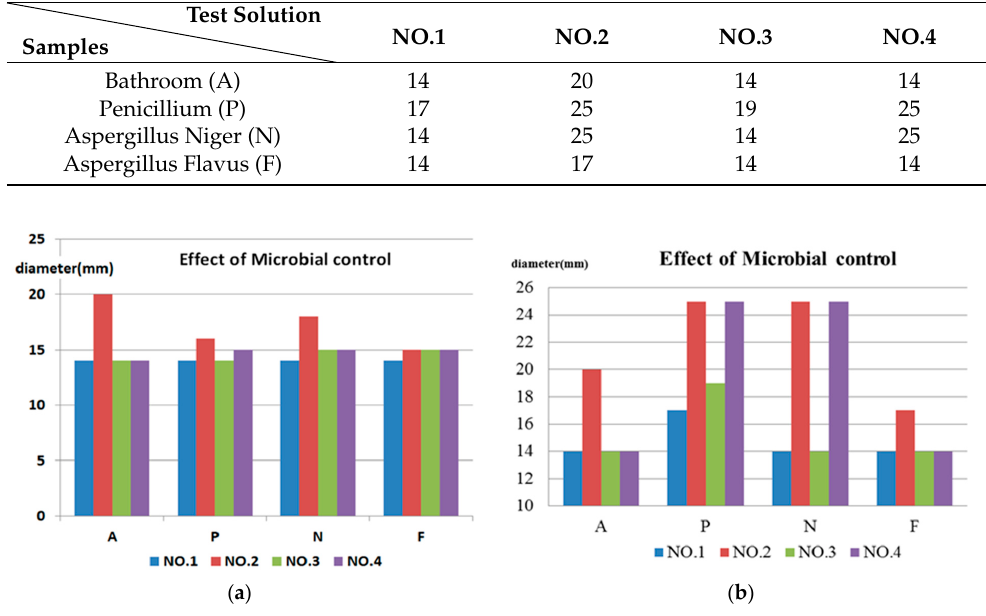
15 Table 9. Results of microbial test (cotton pad), diameter (mm). Test Solution Samples